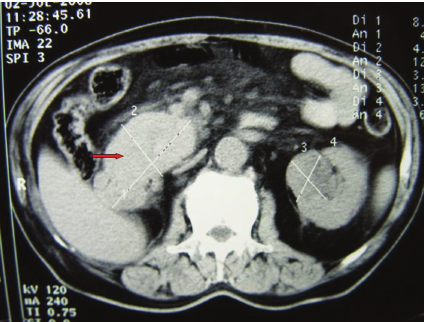
Figure 1: CT examination of the abdomen revealed a mass at the pancreatic head (arrow).